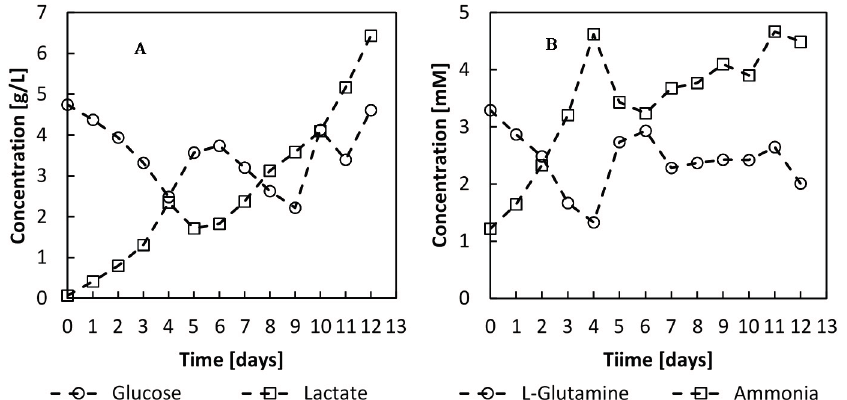
Figure 12. Metabolite concentrations during the batch and perfusion phases of the culture.